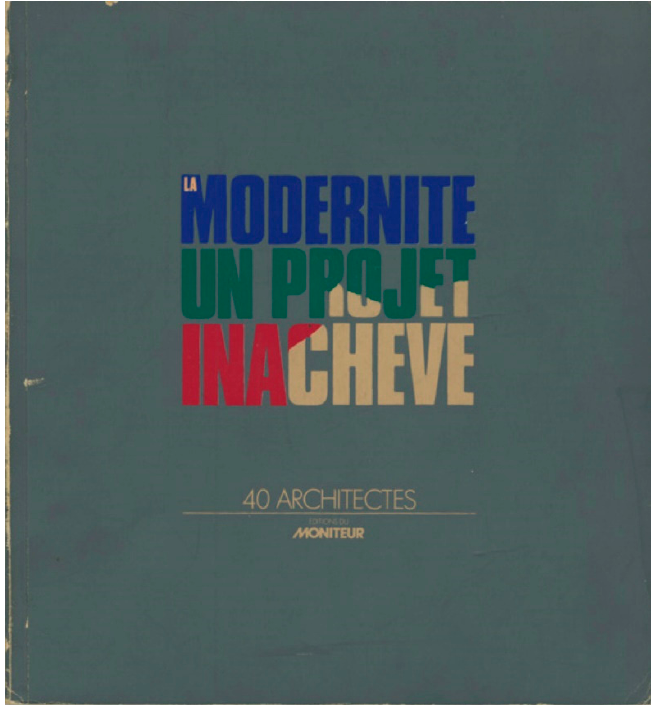
Figure 1. Front cover of Paul Chemetov, Jean-Claude Garcias, eds. 1982. La Modernite ́ , un